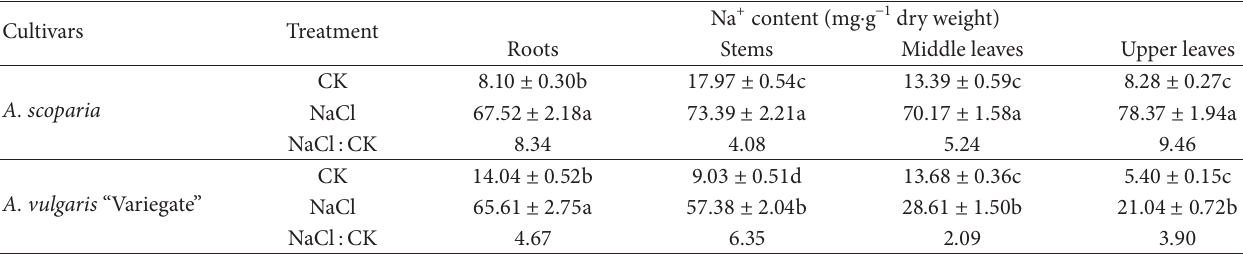
Table 1: Effects of NaCl stress on Na + content in different organs of A. scoparia and A. vulgaris “Variegate.” Cultivars